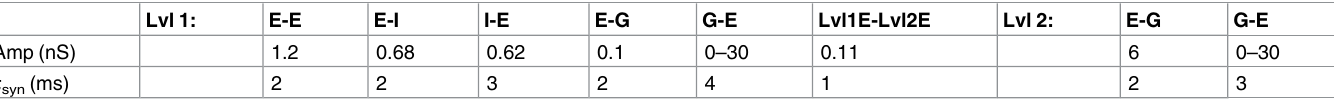
j , and σ sets the decay with distance. In all simulations reported here, σ d degrees, and σ to 4 pixels. Again, the intention is not to implement a detailed model of V1, but d to include non-arbitrary recurrent synaptic connections between excitatory cells, with potential implications for the generation of synchronized activity. Synaptic connections to and from the local inhibitory layer had a 2D Gaussian spread (standard deviation 4 cells), and there was no Table 2. Synaptic parameters values. These are indexed accordingto the connected cells (excitatory E, inhibitoryI and global G), e.g. E-I indicates the synapses from excitatory to inhibitorycells. Where relevant, the amplitudeindicates the maximum synaptic amplitudebetween nearest neighbours,e.g. before applyingthe 2-D Gaussian weightingfor